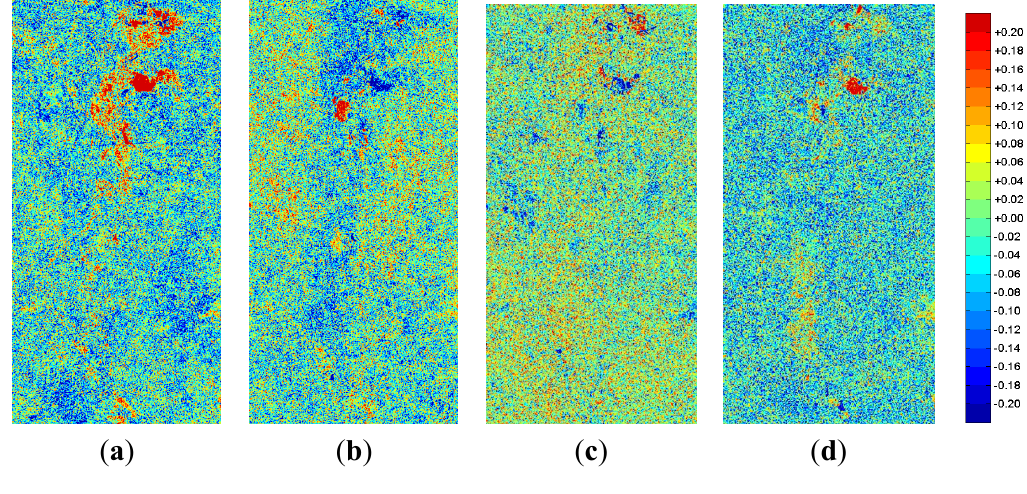
Figure 3. Cloude-Pottier entropy changes between sequent acquisitions (without unit): ( a ) April to May; ( b ) May to June; ( c ) June to July; and ( d ) July to